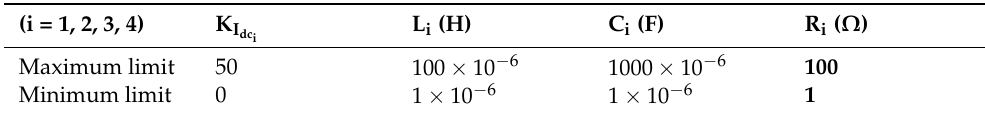
Table 6. The limits values of parameters of integral controllers and DC/DC converters’ components for Optimizer